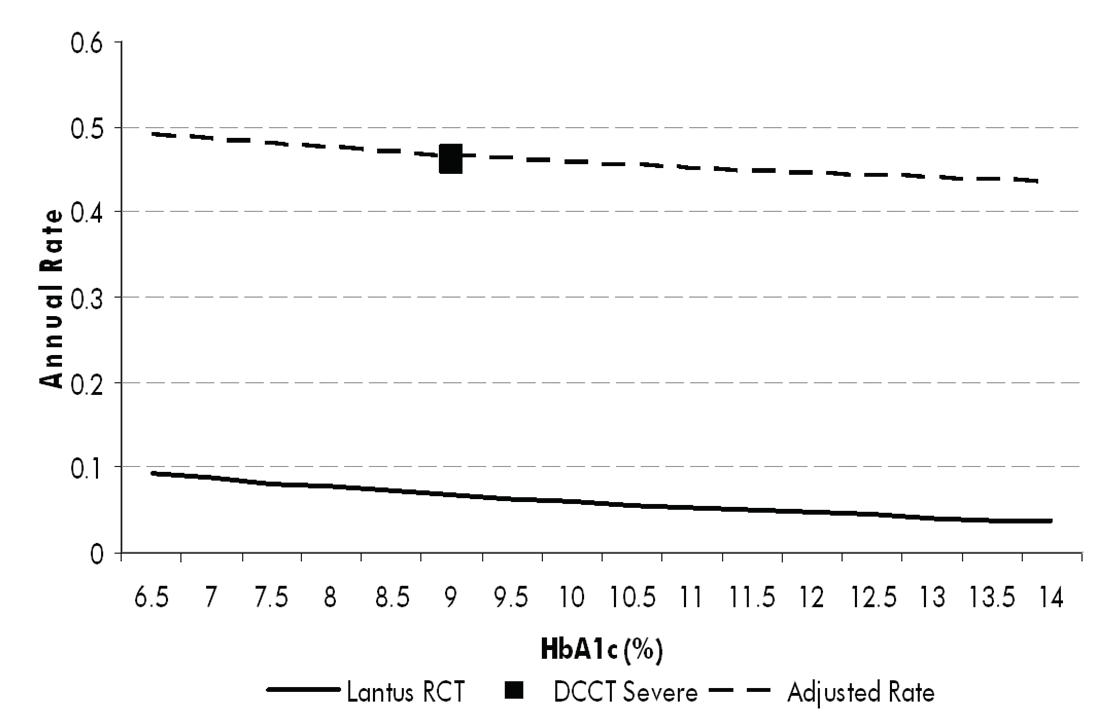
Figure 3. Illustrating Re-calibration of the Mullins Meta-regression Equations; for Setting HbA1c-specific Levels of Baseline